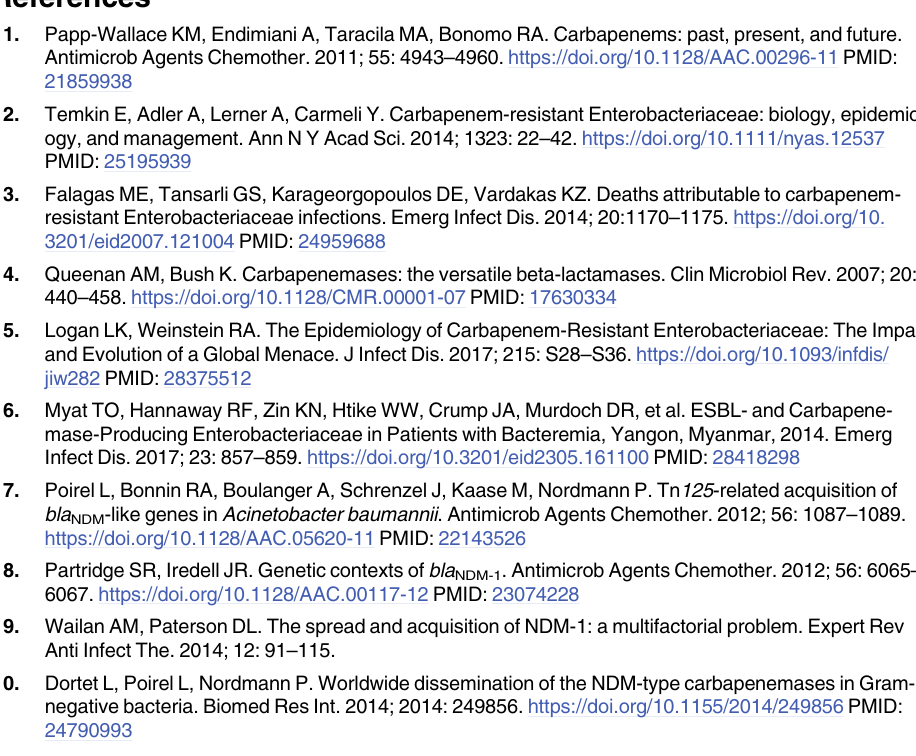
S1 Table. Antimicrobial resistance determinants carried by the plasmids identified in E . coli clinical isolates in